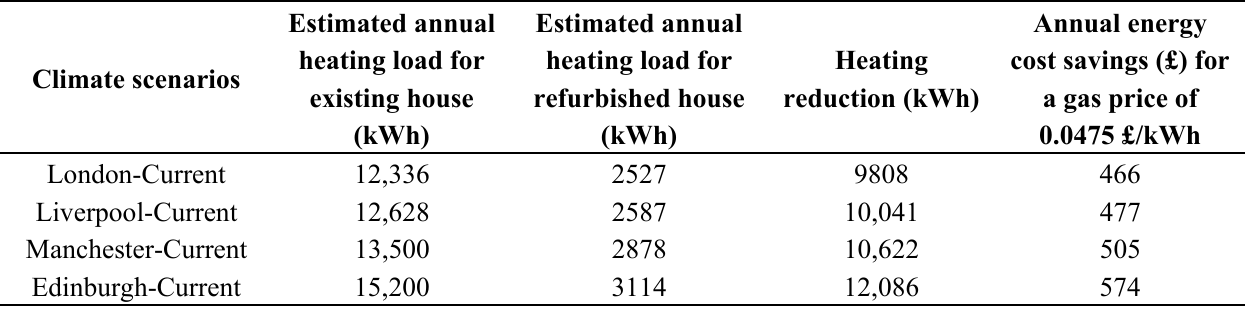
Table 8. Annual savings from lower gas consumption for heating—current weather data.